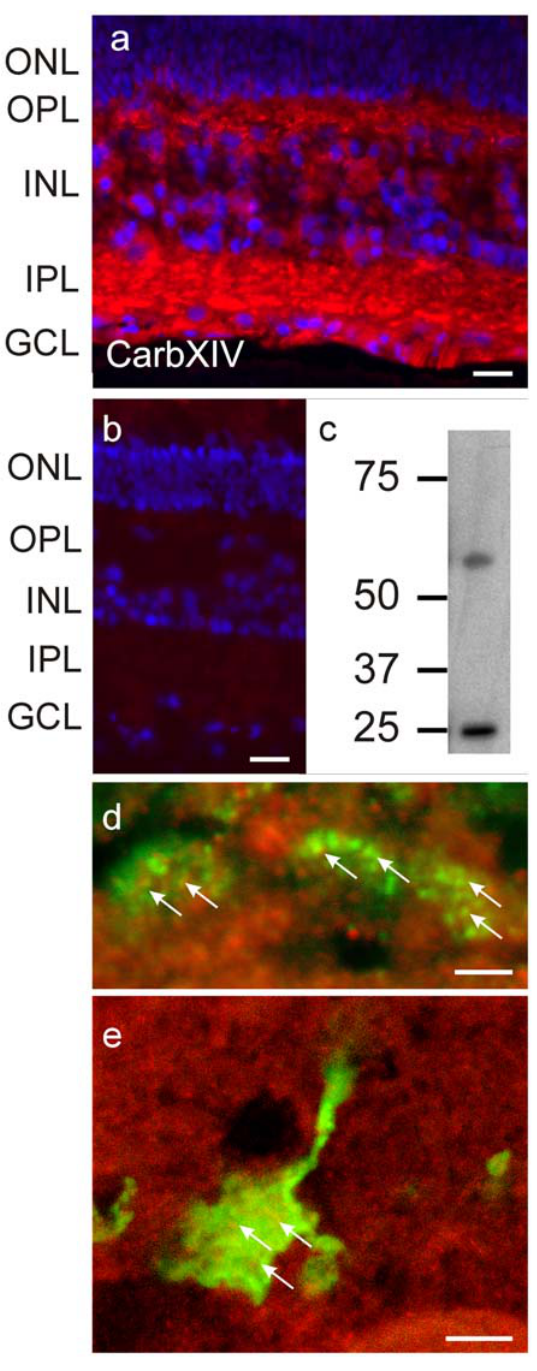
Figure 7. Localization of extracellular carbonic anhydrase XIV in the goldfish retina. A , Distribution of the extracellular carbonic anhydrase in the goldfish retina. Immunostaining by an antibody raised against the mouse extracellular carbonic anhydrase XIV was found throughout the goldfish retina. Extensive labeling (red) was found throughout the OPL, suggesting a role for extracellular carbonic anhydrase in synaptic transmission between cones and horizontal cells. The blue label is due to the nuclear marker DAPI. ONL: outer nuclear layer, OPL: outer plexiform layer, INL: Inner nuclear layer, IPL: inner plexiform layer. B , No label remains after pre-adsorption of the primary antibody with the immunizing recombinant carbonic anhydrase XIV. Scale bars in A and B =20 m m. C , Western blot of membrane fractions of goldfish retina shows a band at about 57 kDA and a band at 25